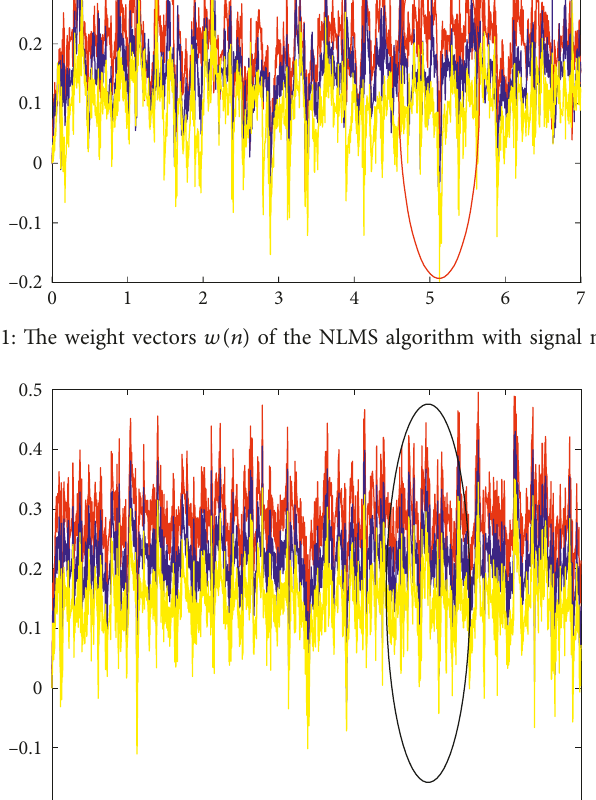
n of the improved LMS algorithm with signal ( )